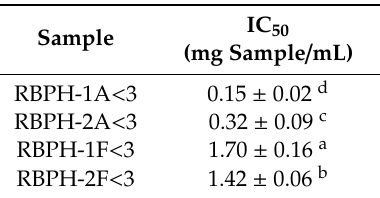
Table 3. Inhibition of the angiotensin-converting enzyme (ACE) expressed as IC 50 presented by the fractions with molecular mass smaller than 3 kDa from defatted rice bran protein hydrolysates (RBPH-1A < 3, RBPH-2A < 3, RBPH-1F < 3, and RBPH-2F < 3). The values are given as the means ± standard deviation of three measurements. The same letters indicate no statistical di ff erences ( p > 0.05). Significance was estimated using one-way